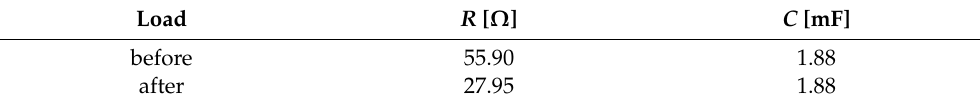
Table 19. Load parameters for steady states before and after load change. Load before after U rms = 230 V, f = 50 Hz, 5-phase supply system .